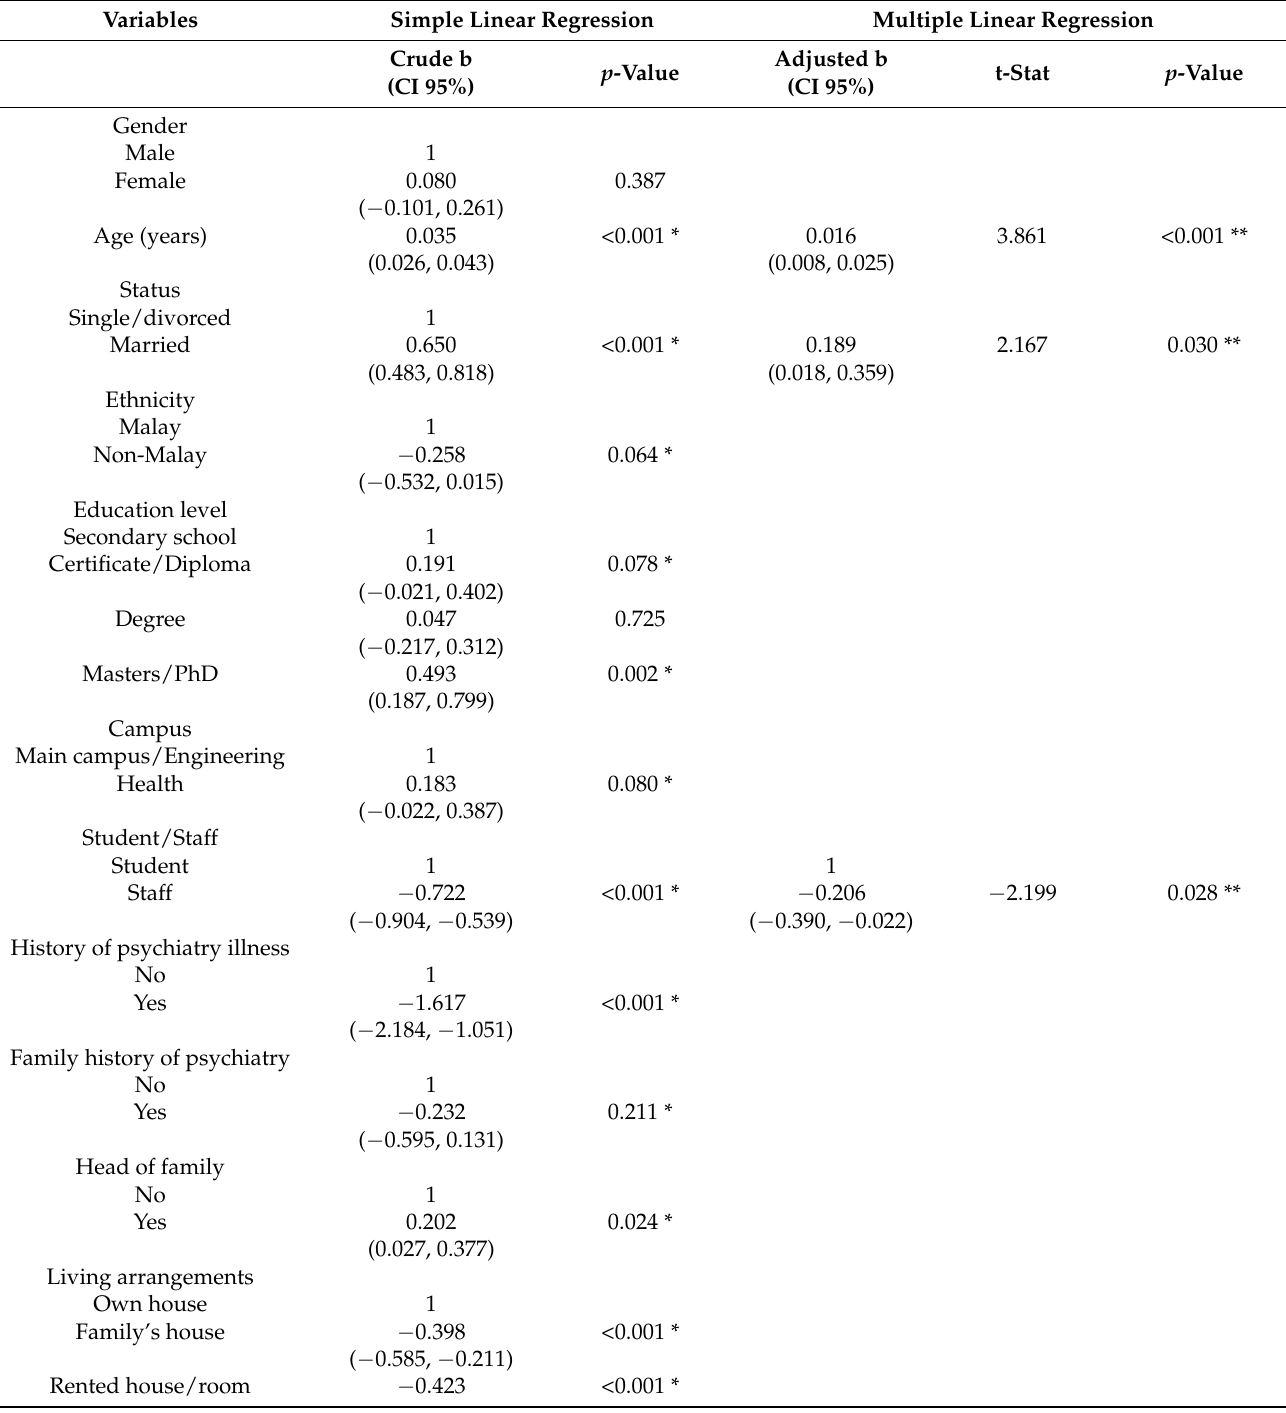
Table 5. Factors associated with subjective